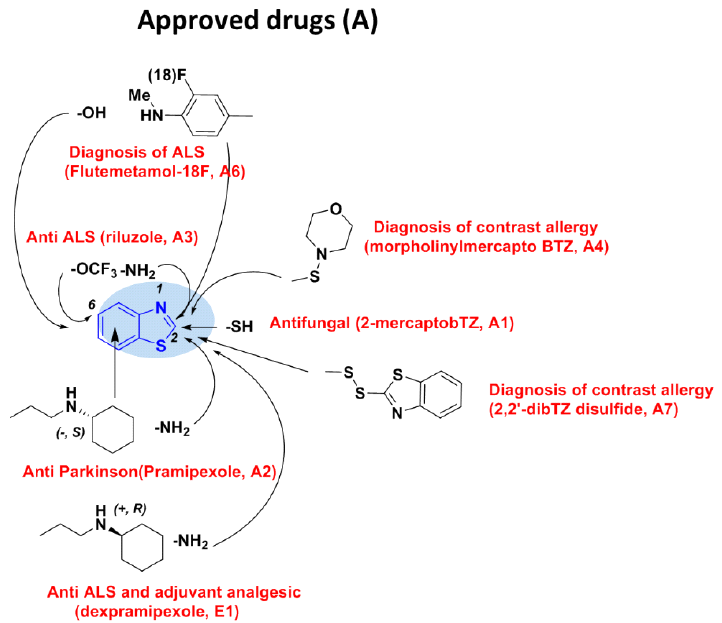
Figure 4. Substituents displayed by the approved 1,3-benzothiazole drugs included in DrugBank [3]; dexpramipexole (E1) was included.